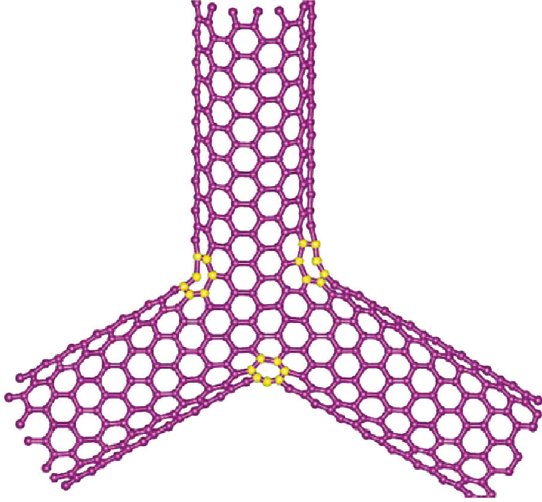
Figure 3: A variant of Y -junction Y 2